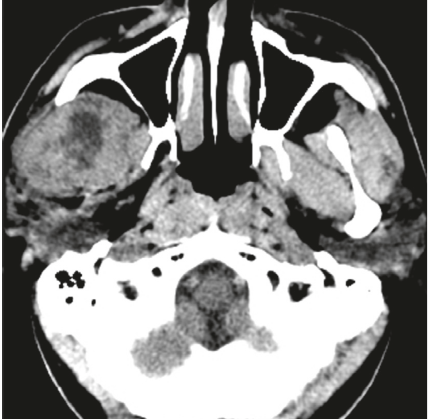
Figure 4: Preoperative CTscan shows the recurrent ameloblastoma in the infratemporal fossa.